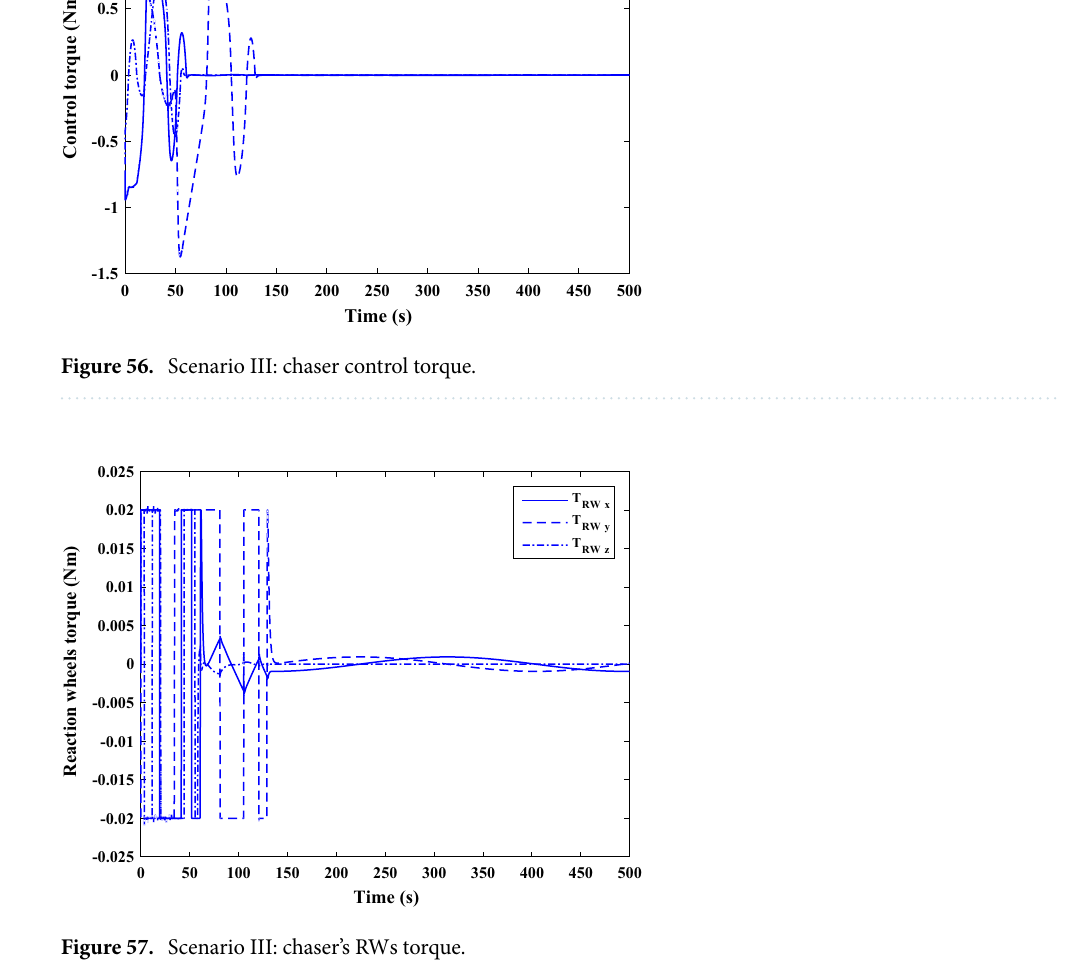
Figure 57. Scenario III: chaser’s RWs